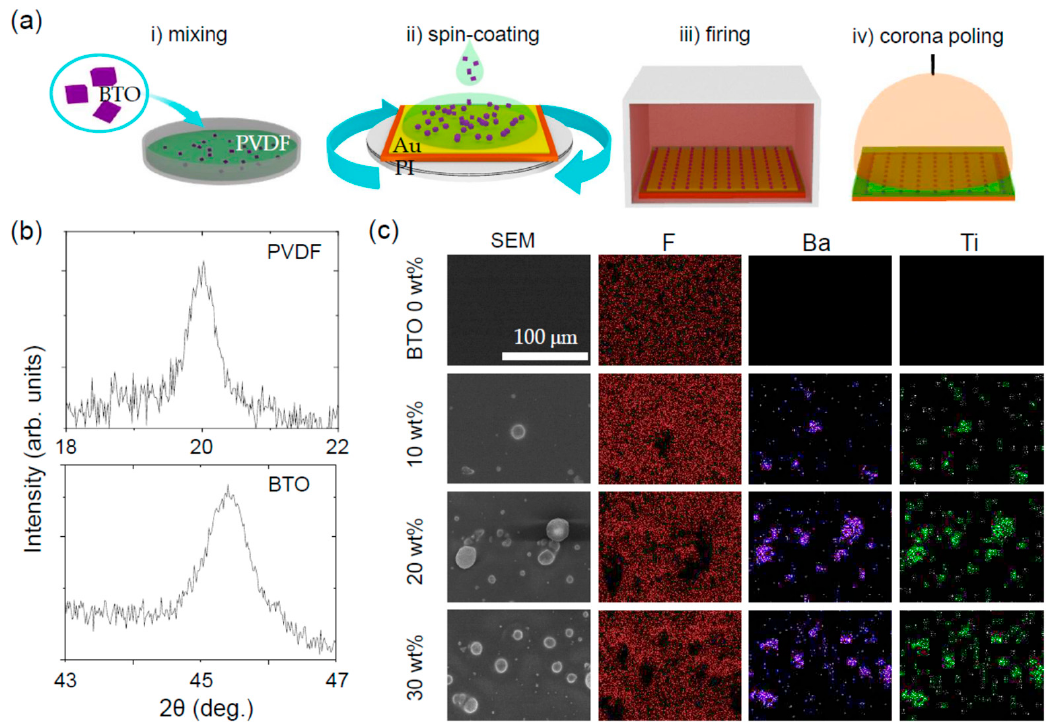
Figure 1. ( a ) Schematic diagram of the fabrication process of a poly(vinylidene fluorine)–BaTiO 3 (PVDF–BTO) composite. ( i ) Mixing, ( ii ) spin-coating, ( iii ) firing, and ( iv ) coronal poling. ( b ) Magnified X-ray diffraction patterns at selected angles. ( c ) Scanning electron microscopy (SEM) images and energy-dispersive X-ray (EDX) spectral maps for F, Ba, and Ti atoms.